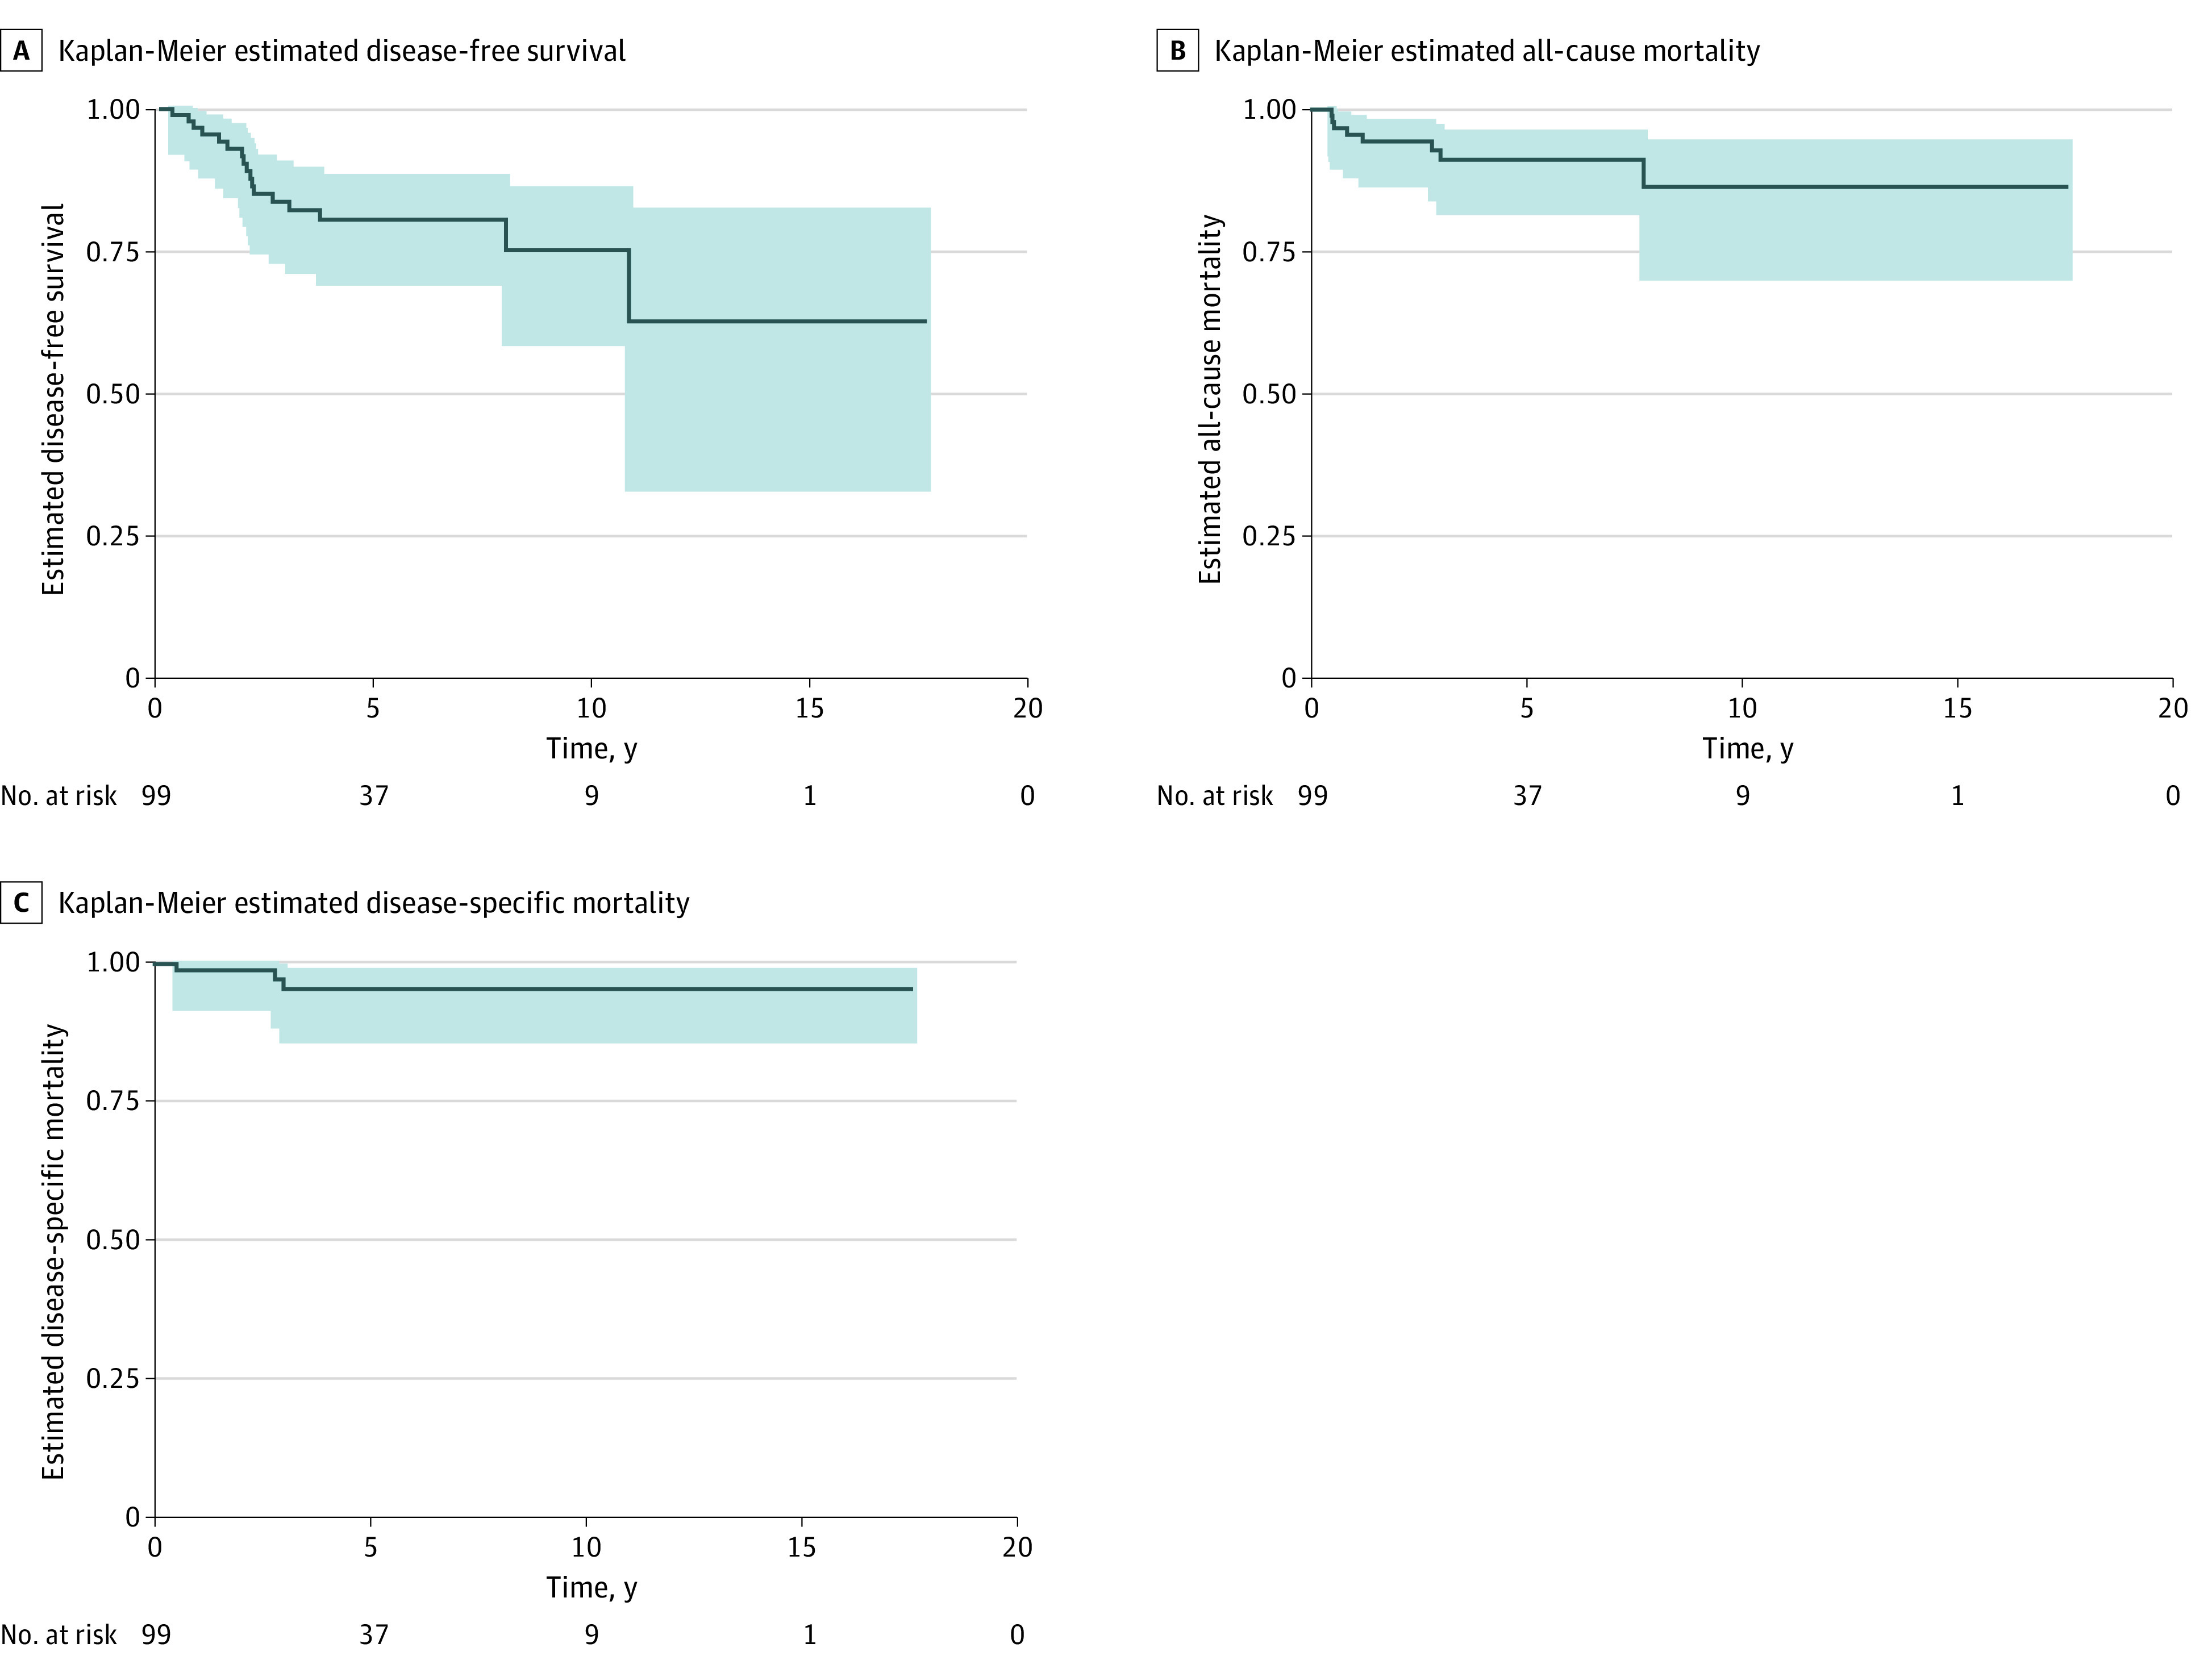
Risk-Adjusted Kaplan-Meier Curves of Patients With Locally Advanced Pancreatic Neuroendocrine Tumor According to Postsurgical Resection Status